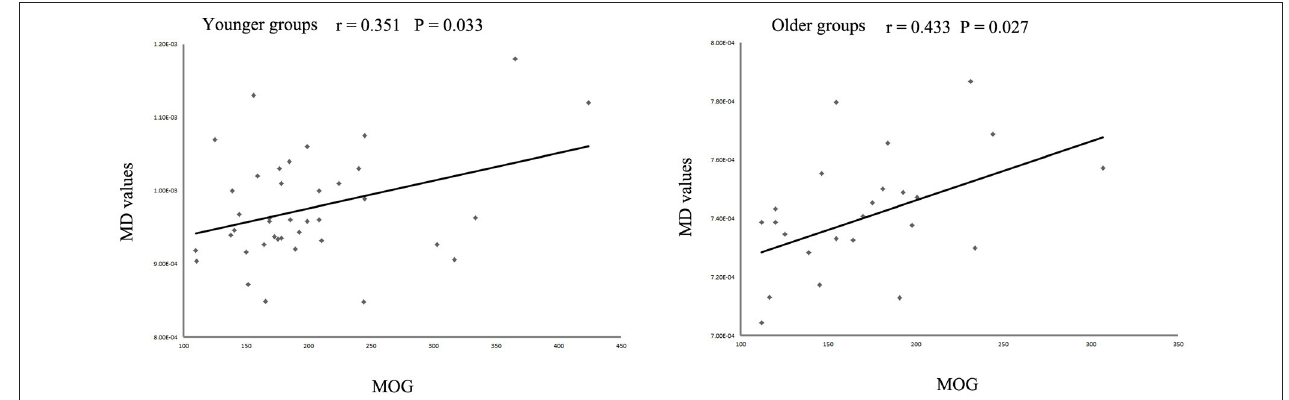
FIGURE 3 | Scatter plots showing significant correlations between myelin oligodendrocyte glycoprotein (MOG) concentration and mean diffusivity (MD) values in the left inferior fronto-occipital fasciculus in different age groups.